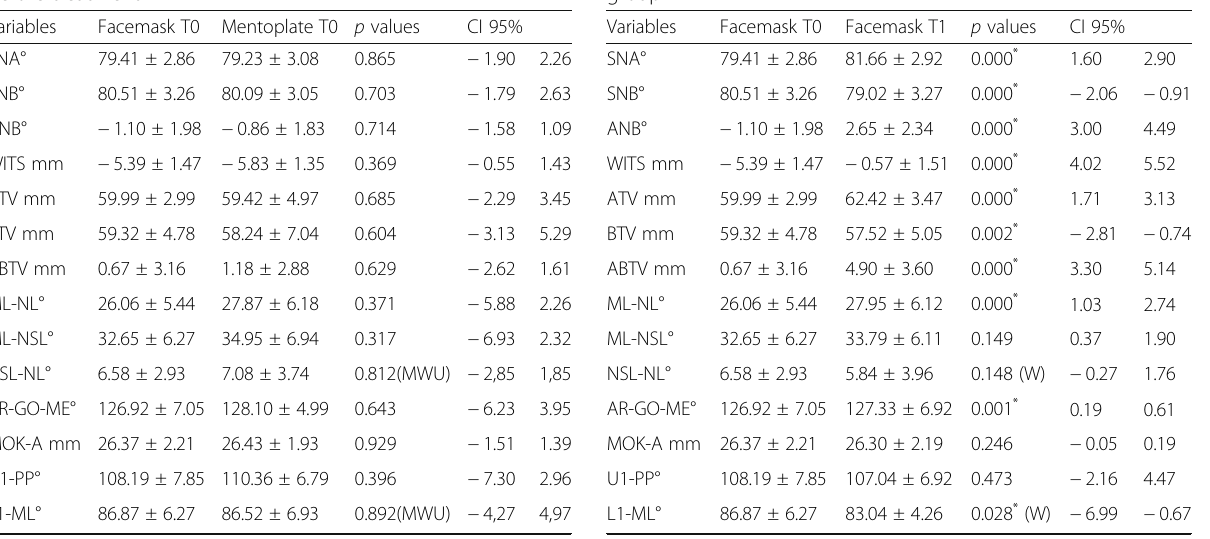
Table 5 Skeletal and dental treatment effects in the facemask group